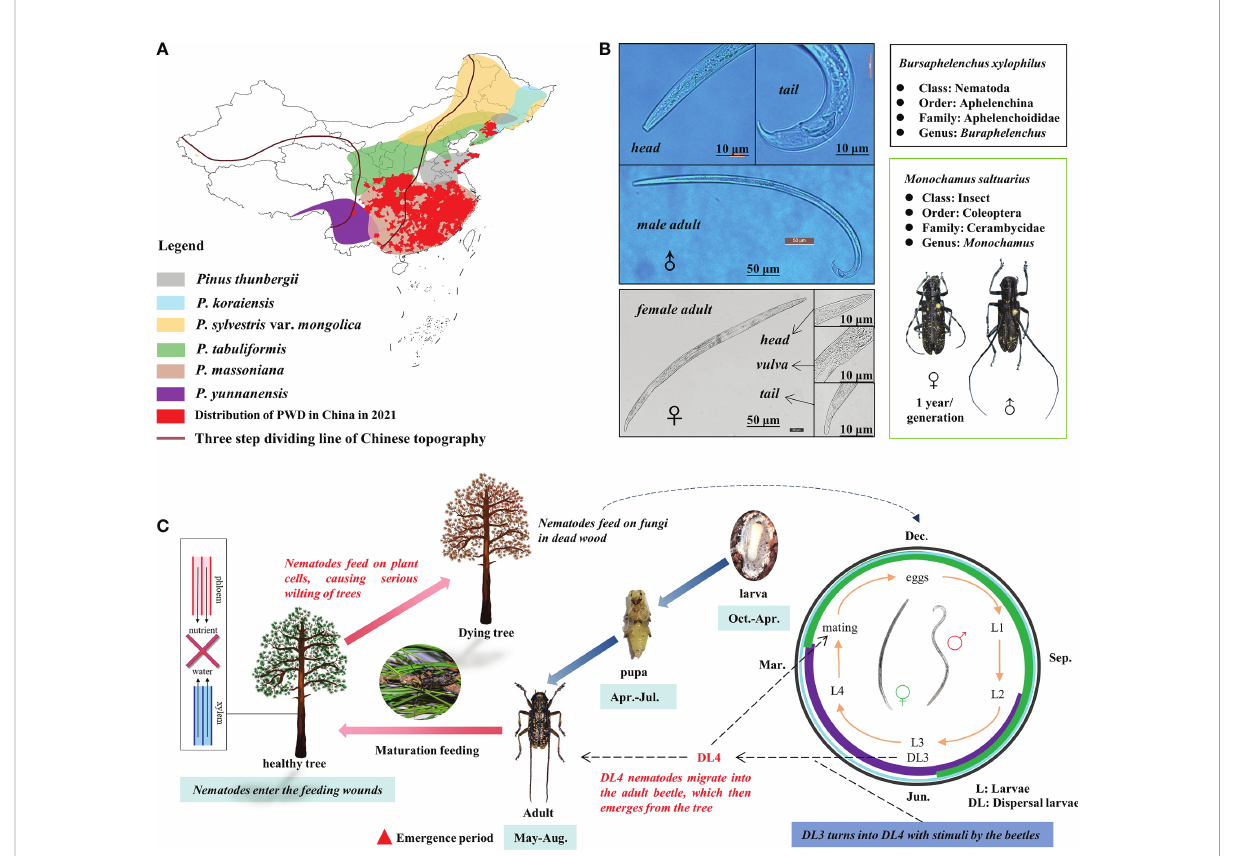
FIGURE 1 Distribution of pine wilt disease in China in 2021 (A) , morphology of Monochamus saltuarius and Bursaphelenchus xylophilus (B) , and pathogenic mechanism of pine wilt disease (PWD) (C)